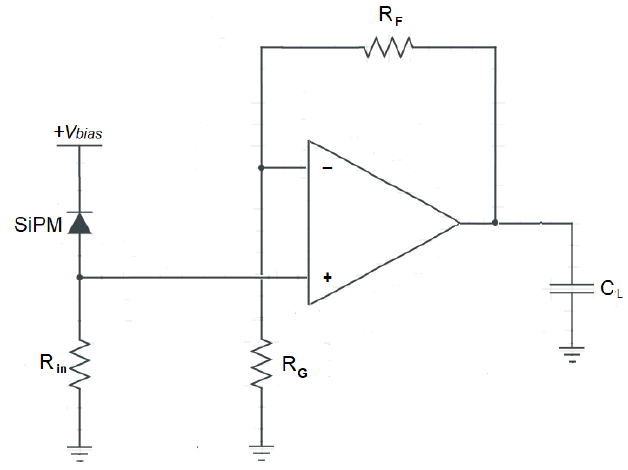
Figure 12. A voltage-mode preamplifier, based on an op-amp.